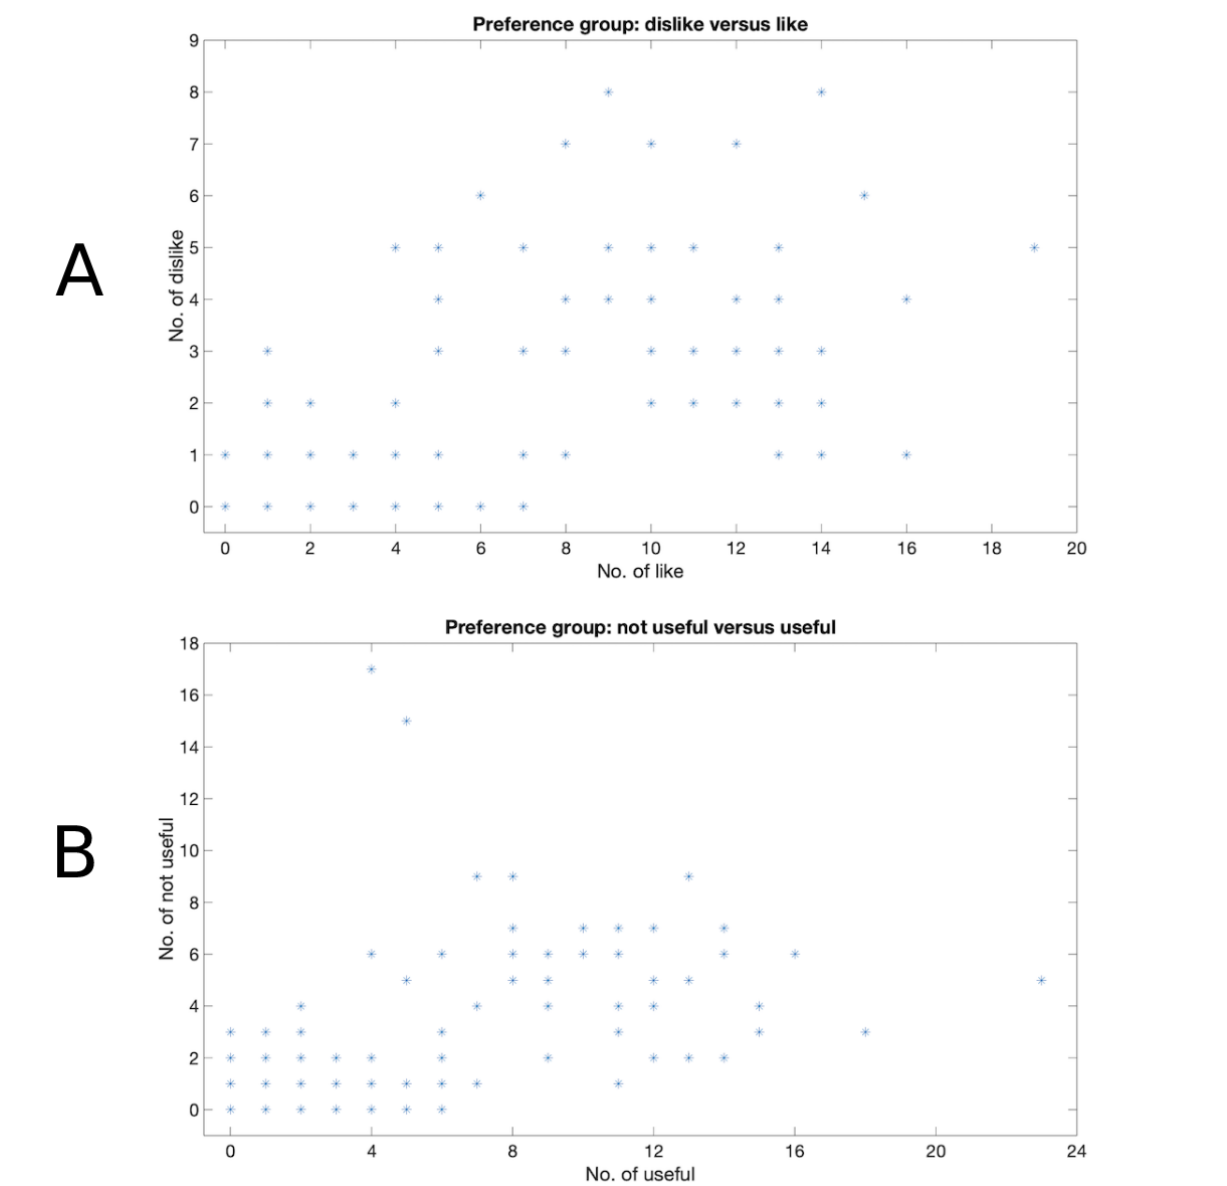
Figure 4. Different preference groups among the SMS message response rating for participants in the pilot study. A: Preference group: Dislike vs Like; B: Preference group: Not useful vs